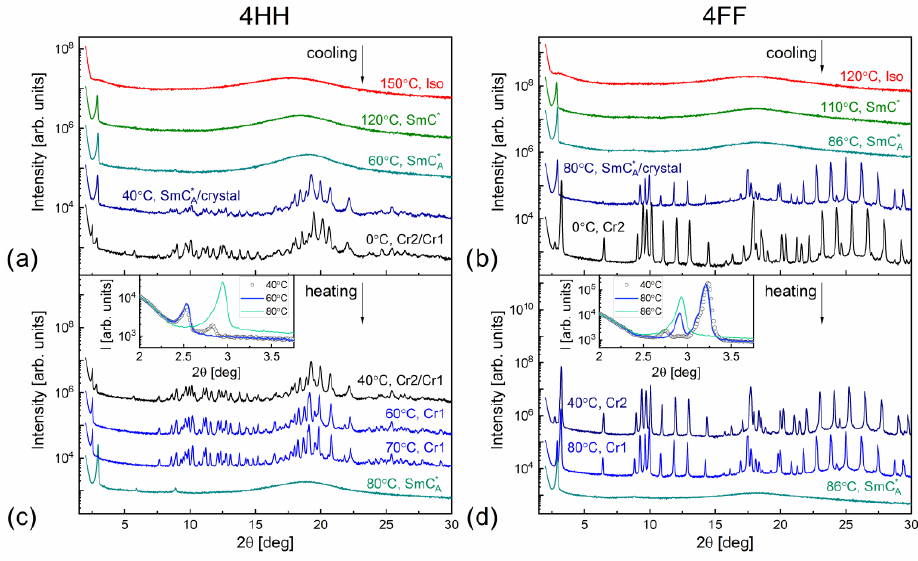
Figure 4. XRD patterns collected on cooling ( a , b ) and heating ( c , d ) for 4HH ( a , c ) and 4FF ( b , d ). For 4HH, as the cooling rate increases, an additional anomaly becomes visible in the DSC curves in a proximity to a larger anomaly originating from crystallization (inset (1) in Figure 3a). Because the area of this anomaly is small ( ∆ H ≈ 1.5 kJ/mol), it can be interpreted as the transition between the SmC A∗ phase and monotropic, more-ordered smectic phase, denoted here as SmX ∗ . It could be the hexatic phase reported previously for the 5HH compound from the same series [16]. In the POM observations for 4HH, a change of texture, visible mainly as a colour saturation, is observed below 30 ◦ C (Figure 2a, 26 ◦ C). That supports the hypothesis of the third smectic phase. On further cooling, another transition is visible at 23 ◦ C. The change in texture is mostly in colour (Figure 2a, 20 ◦ C) and the overall texture still resembles these observed for SmC ∗ and SmX ∗ . However, ∆ H value at this transition obtained by DSC is 11.1 kJ/mol, the largest enthalpy change on cooling, which implies the crystallization of